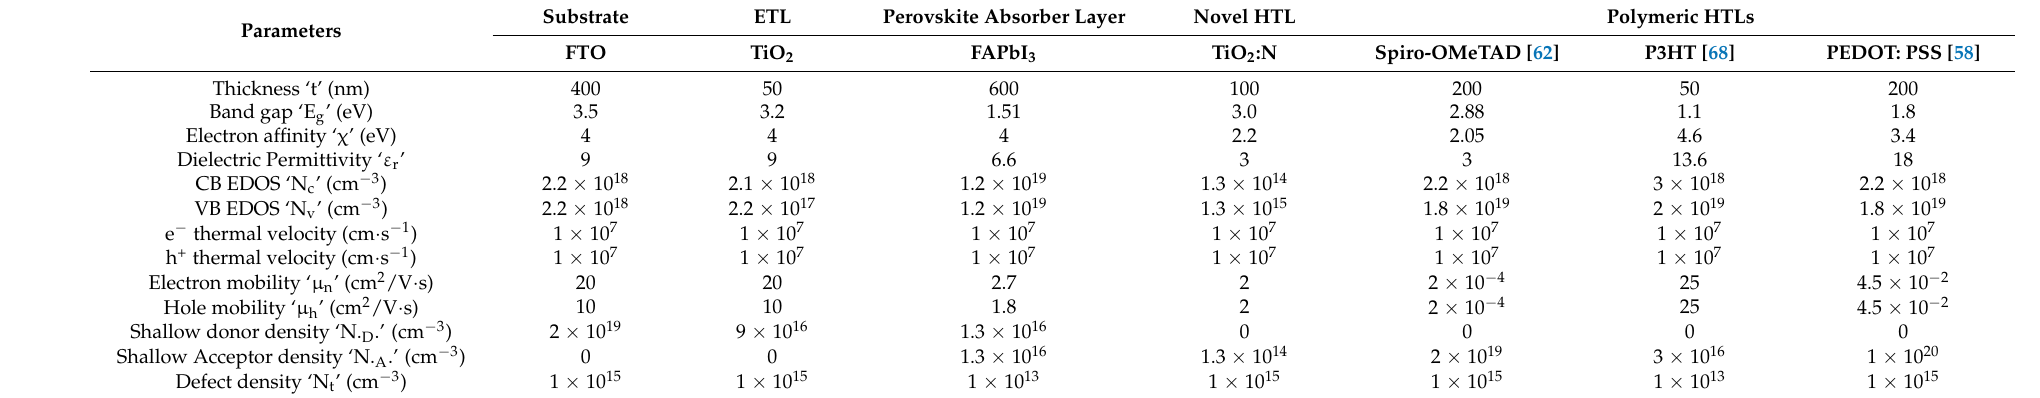
Table 7. Simulation parameters for TiO 2 :N and Polymeric